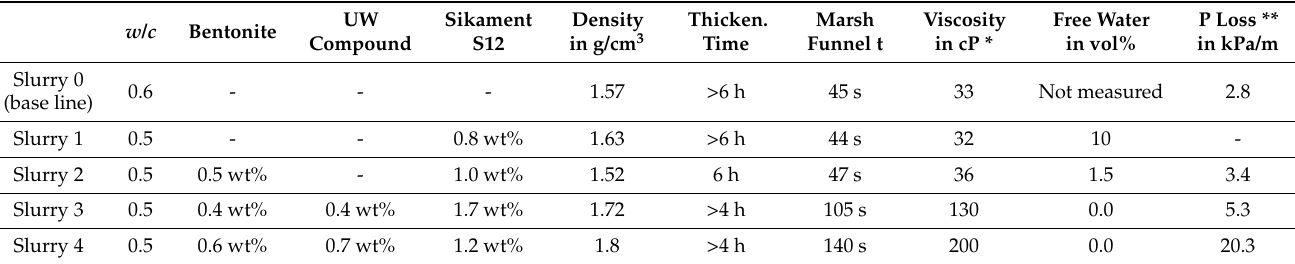
Table 5. Cement properties of slurries tested by the BRP for borehole